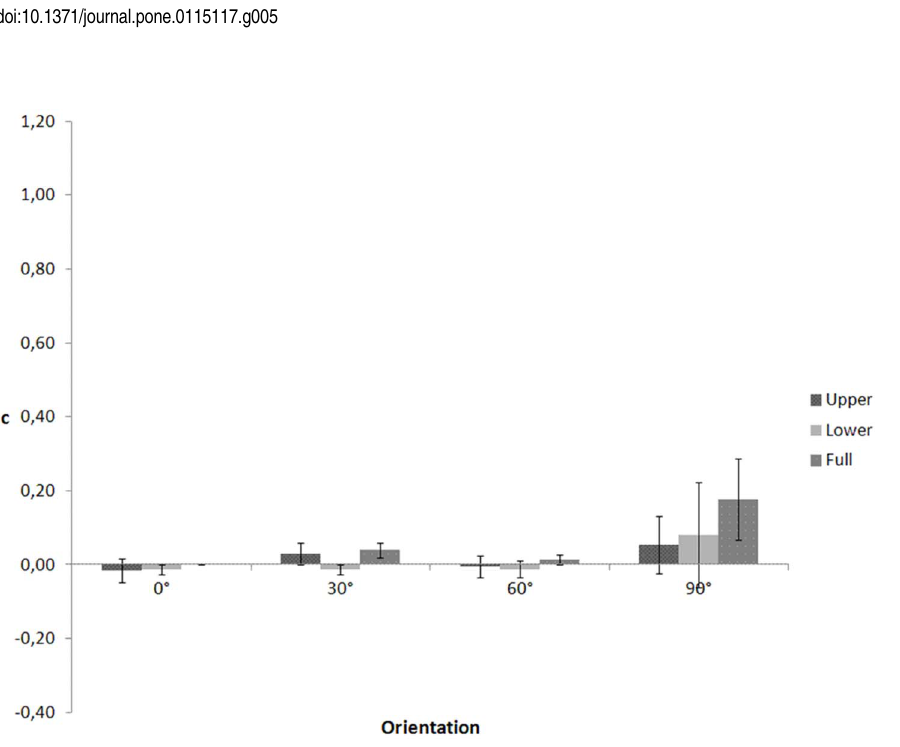
Fig. 6. c as a function of visible body part and figure orientation for the crawling action in Experiment